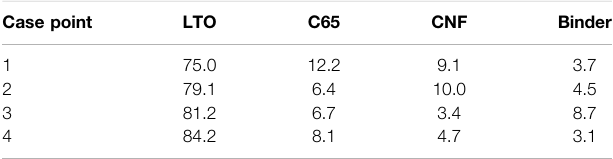
TABLE 2 | Randomly selected sample points for the analysis of local component effects.